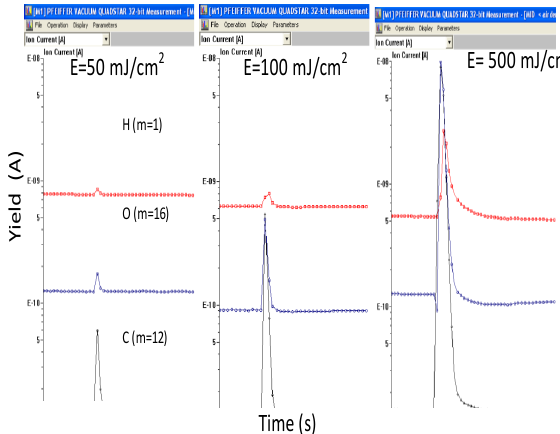
Fig. 4. Typical MQS spectra of emitted C, O and H as a function of the time and of the laser pulse energy density.